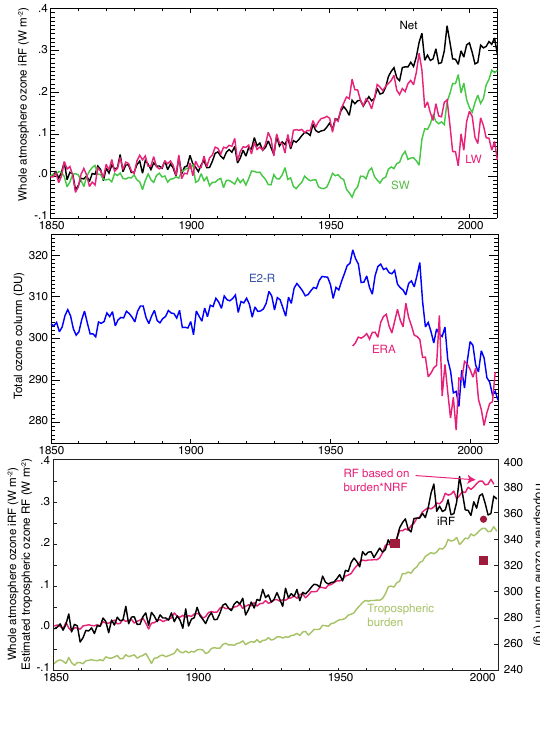
Fig. 15. Historical evolution of ozone burdens and radiative forc- ing. Time varying instantaneous tropopause radiative forcing due to ozone (Wm − 2 ) from the transient simulations (top; as longwave (LW), shortwave (SW) and net), total column ozone (DU) in the model and in ERA reanalysis (middle), and iRF along with the tro- pospheric ozone burden (DU) and ozone RF estimated using the tropospheric burden times the normalized radiative forcing (NRF) (bottom). The solid red symbols in the lower panel show the whole atmospheric (square) and tropospheric (circle) ozone RF calculated in the offline radiative transfer